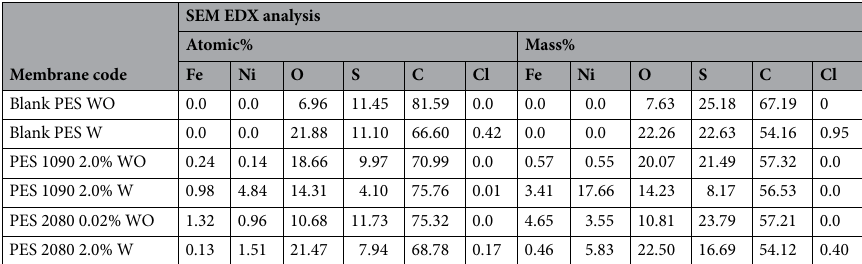
Table 2. EDX analysis of the fabricated membranes using SEM equipment.